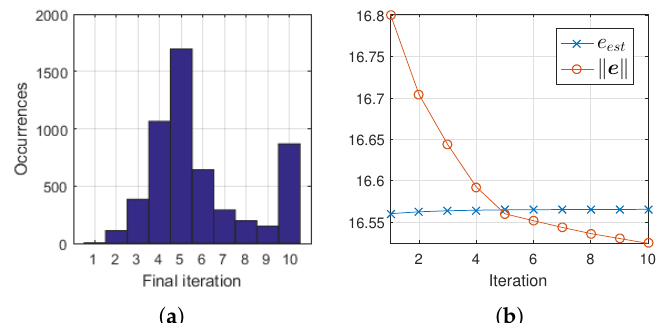
Figure 7. ( a ) histogram of final iteration (when e est ≥ (cid:107) e (cid:107) for the first time) for OMPED running with the SVD dictionary, for K varying from 2 to 10. Results from all values of K are summed. The total number of reconstructions is 5400. The 5th iteration was more frequently identified as final iteration, which is correct since all simulated acquisitions contained 5 scatterers; ( b ) example of evolution of e est and (cid:107) e (cid:107) along the iterations of OMPED. In this case, e est dropped below (cid:107) e (cid:107) at the 5th iteration, which was correctly identified as the final iteration. The simulated object contained five scatterers. White Gaussian noise with σ = 0.12 was added to the acquired data. OMPED was ran with the SVD dictionary with K = 8.